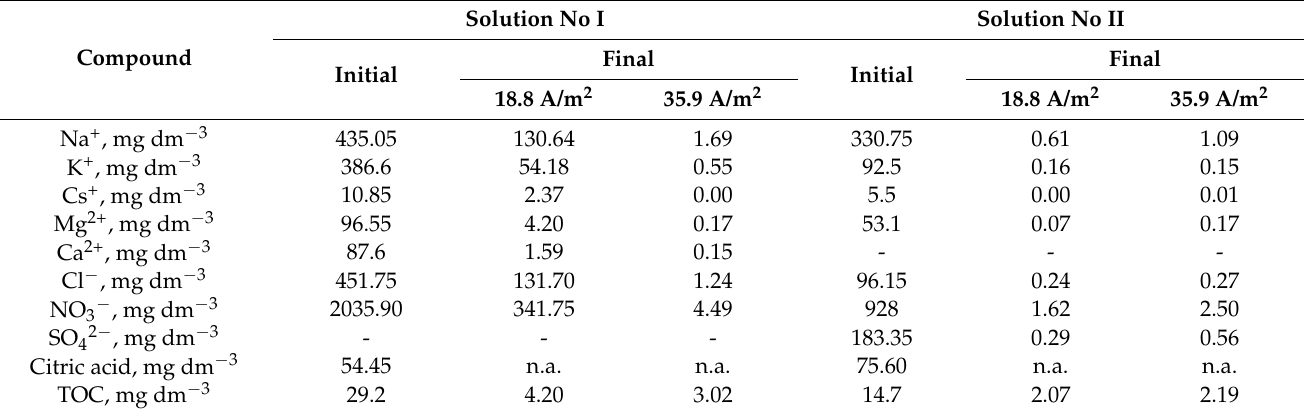
Table 3. The treatment of model solutions containing citric acid using